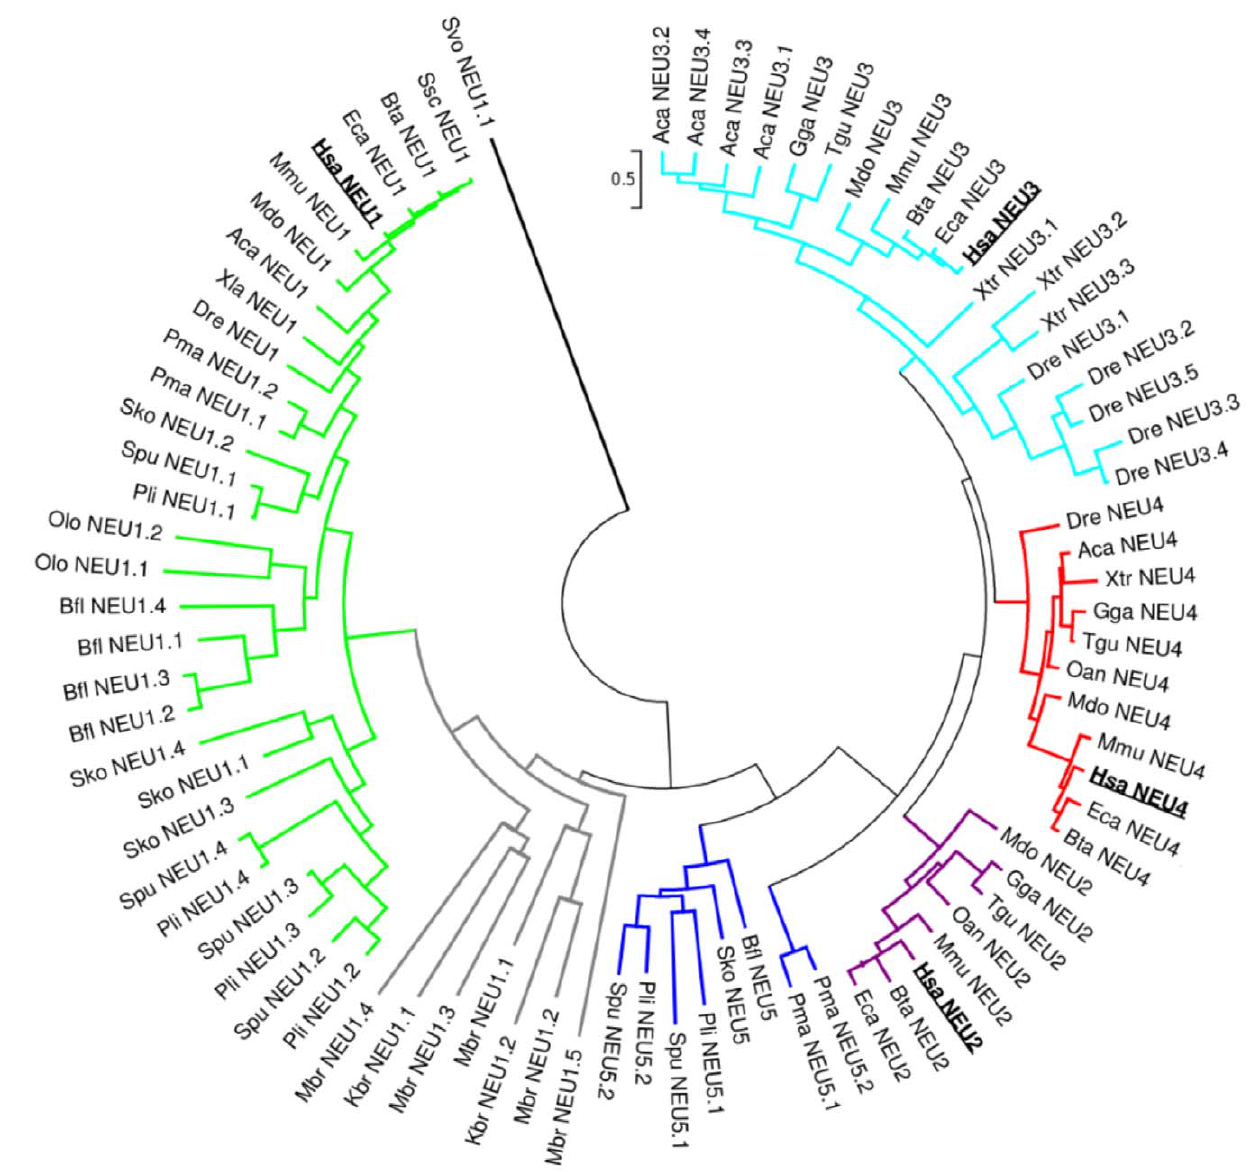
Figure 8. Complete phylogenetic tree of the sialidase gene family. Complete phylogenetic tree of the sialidase gene family reconstructed using Maximum Likelihood method and WAG + G amino acid substitution model. The tree is drawn to scale, with branch lengths measured as number of substitutions per site. The tree with the highest log likelihood (-38941.9521) is shown. Human sialidases are reported in bold. Different subgroups are represented with different colors: NEU1 in green, NEU2 in purple, NEU3 in cyan, NEU4 in red and NEU5 in blue. Branches containing the protist K. brevis and the Choanoflagellata M. brevicollis are represented with grey lines. Bootstrap analysis was conducted with 1000 replicates (bootstrap values are reported in detailed trees in Figure 9). Sialidase from the flagellate S. vortens (Svo NEU1) is placed at the tree root. The tree was constructed, visualized and manipulated using MEGA5.